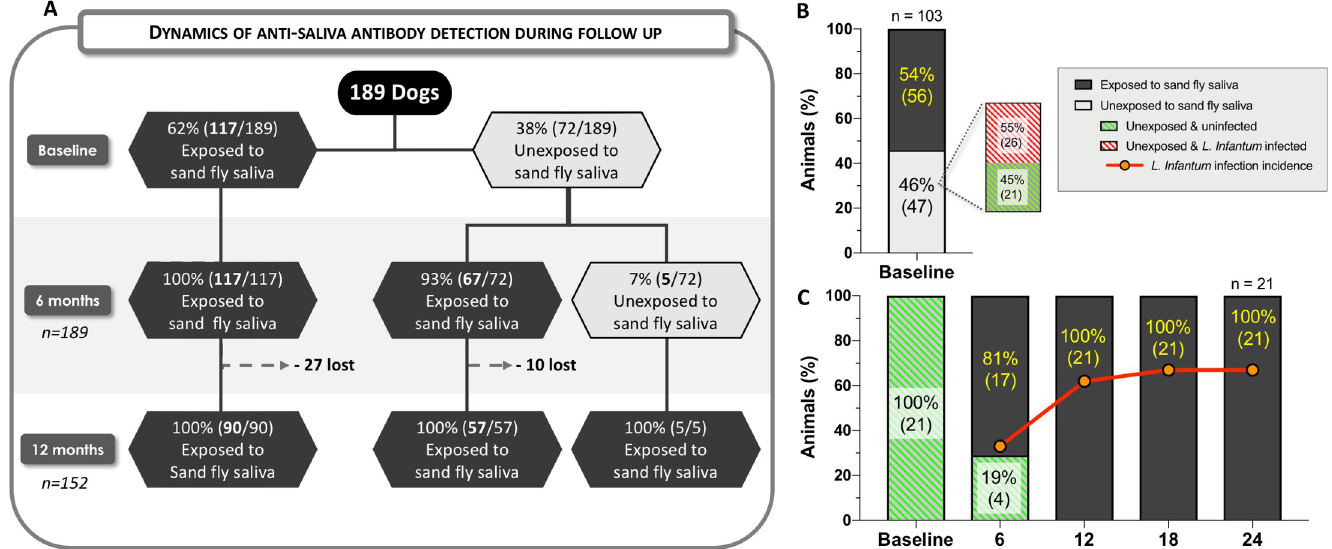
Fig 6. Dynamics of anti-saliva antibody detection and incidence of Leishmania infantum infection. A total of 189 dogs were followed for 24 months, with anti- saliva antibodies measured at six-month intervals by rLJM11+17 ELISA. ( A ) Dynamics of anti-saliva antibody detection of all 189 dogs during the two-year follow-up. Light gray hexagons represent the total number of dogs testing negative for anti-saliva antibodies at each follow-up point; Dark grey hexagons represent animals demonstrating positivity for anti-saliva antibodies; Dotted lines represent a loss to follow-up. ( B ) Percentages of the 103 dogs that completed the two-year follow-up period demonstrated positivity or negativity for anti-saliva antibodies at baseline. ( C ) Dynamics of anti-saliva antibody detection and L . infantum infection incidence in 21 uninfected dogs negative for anti-saliva antibodies at baseline. https://doi.org/10.1371/journal.pntd.0009137.g006 presented a higher median rLJM11+17 RI than dogs classified with lower sandfly exposure ( p < 0.05) (Fig 7A). In the group of animals with higher exposure to vectors, 71% were classified as susceptible to CVL, whereas only 51% were considered resistant, indicating a significant